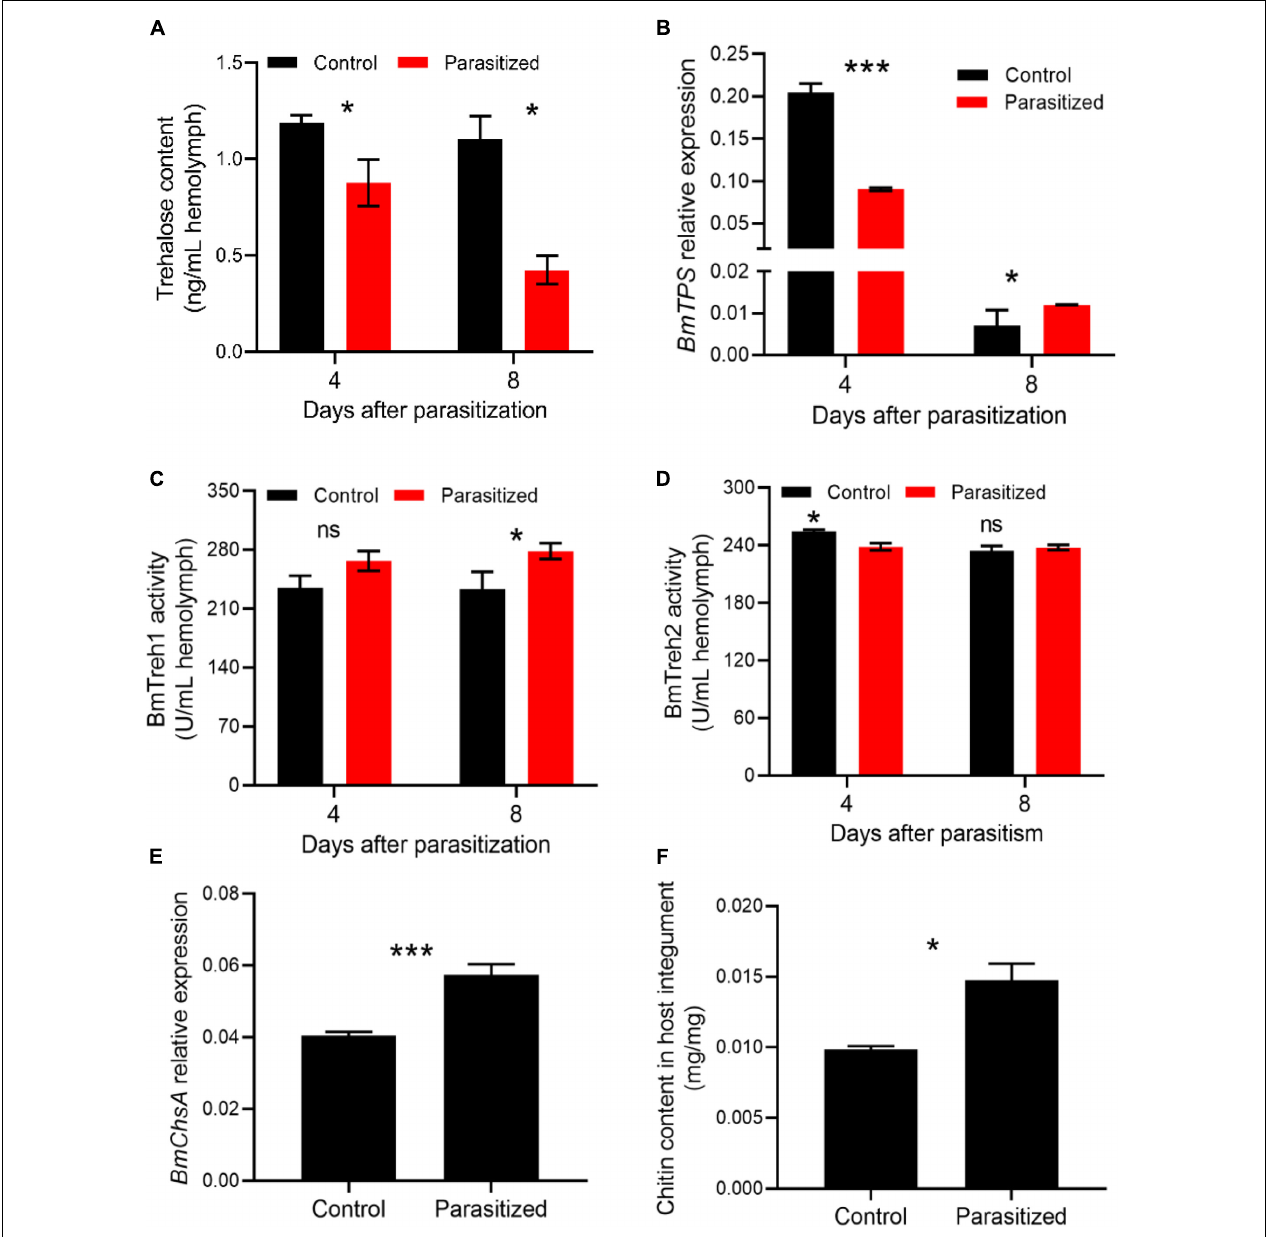
FIGURE 5 | The effect of E . japonica parasitoidism on trehalose metabolism and chitin synthesis. (A) Trehalose content in the hemolymph of silkworm larvae at 4 (silkworm at wandering stage) and 8 (silkworm at prepupal stage) DAP. (B) The expression level of BmTPS in the fat body relative to BmActin3 . (C) BmTreh1 activity in the hemolymph of silkworm larvae at 4 and 8 DAP. (D) BmTreh2 activity in the hemolymph of silkworm larvae at 4 and 8 DAP. (E) The expression level of BmChsA relative to BmActin3 in integument of silkworms at 8 DAP. (F) Chitin content in integument of parasitized silkworms at prepupal stage. All the data were presented as mean ± SD with n = 3. Significance of the results was determined by the Student’s t -test; * P < 0.05, *** P < 0.001, ns not